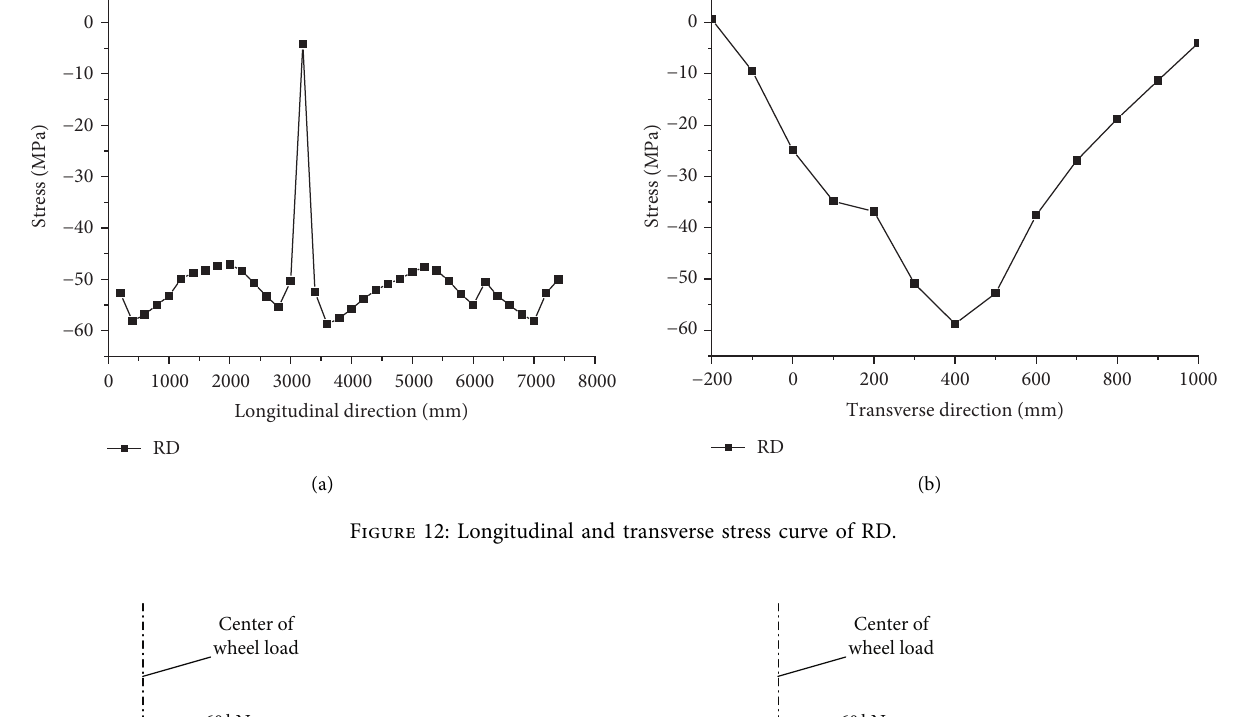
Figure 12: Longitudinal and transverse stress curve of RD.